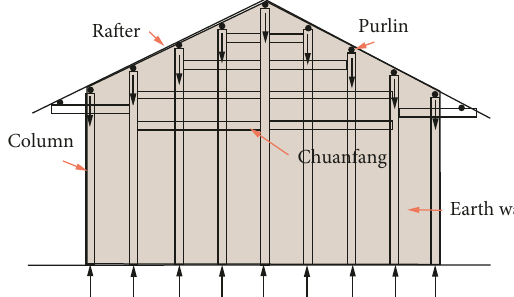
Figure 6: Column-and-tie timber structure with Earth